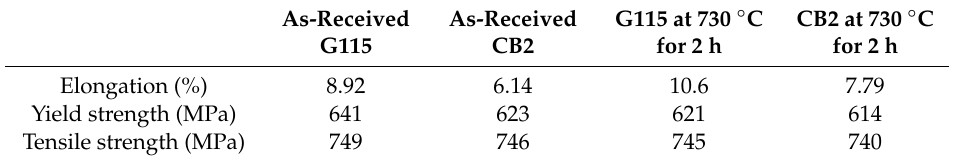
Figure 8. Tensile strengths of the joints of G115 steel and CB2 steel without and with PWHT. Table 2. Elongation, yield strength and tensile strength of the base metals.